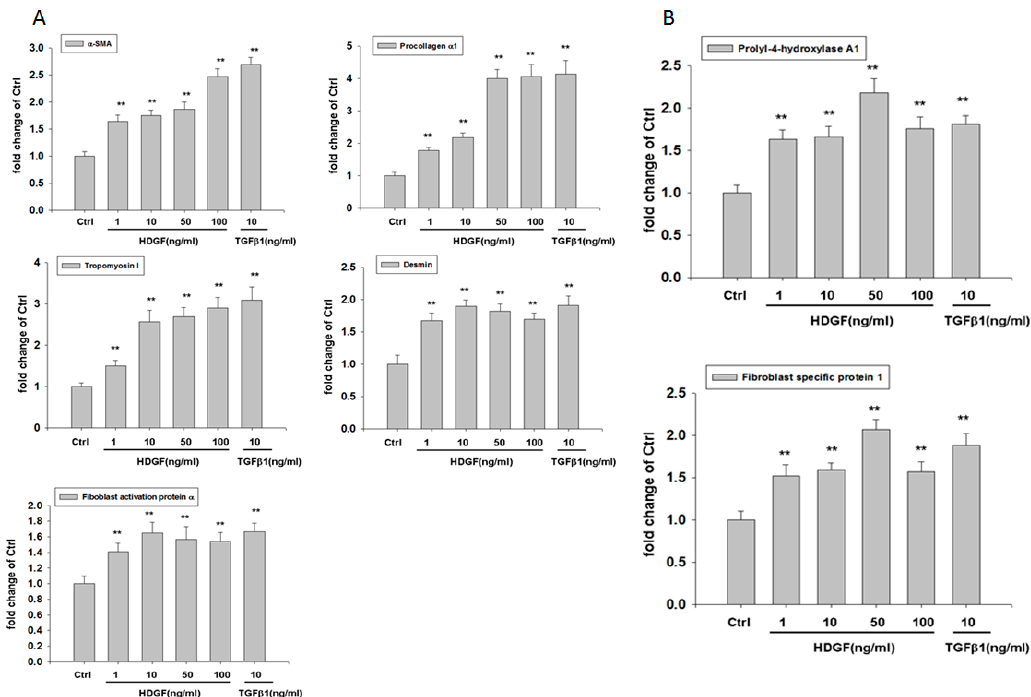
Figure 3. HDGF stimulates expression of myofibroblast ( A ) and fibroblast ( B ) markers in HBMMSCs in various concentrations. HBMMSCs were treated with HDGF (1, 10, 50, 100 ng/ml) for 24 hours. The effect of HDGF on marker expression of myofibroblast and fibroblast were measured by RT q-PCR. TGF β 1 (10 ng/ml) treatment as positive control. ** p < 0.01 versus control (mean ± SD, n = 3).